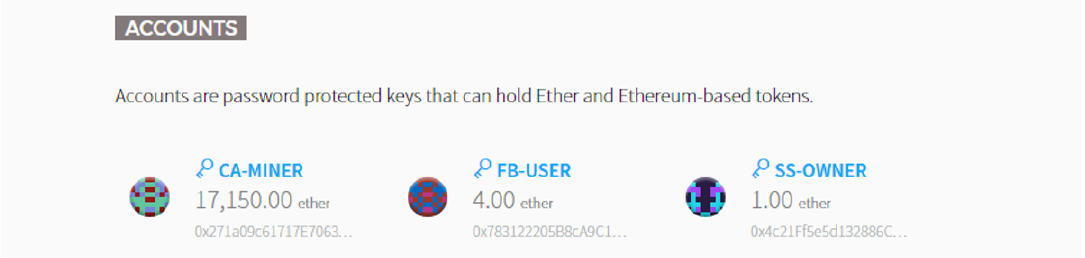
Figure 6. The results before performing the smart contract in